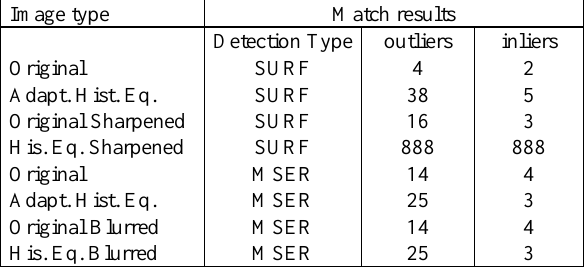
Table 4. Results of the experiment 3